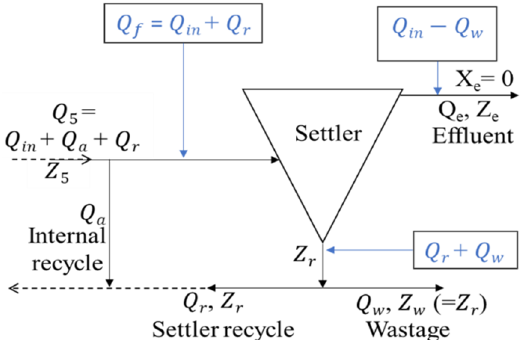
Figure A1. Schematic representation of a perfect settler. Symbols: Q f : Settler feed flowrate, Q in : In-